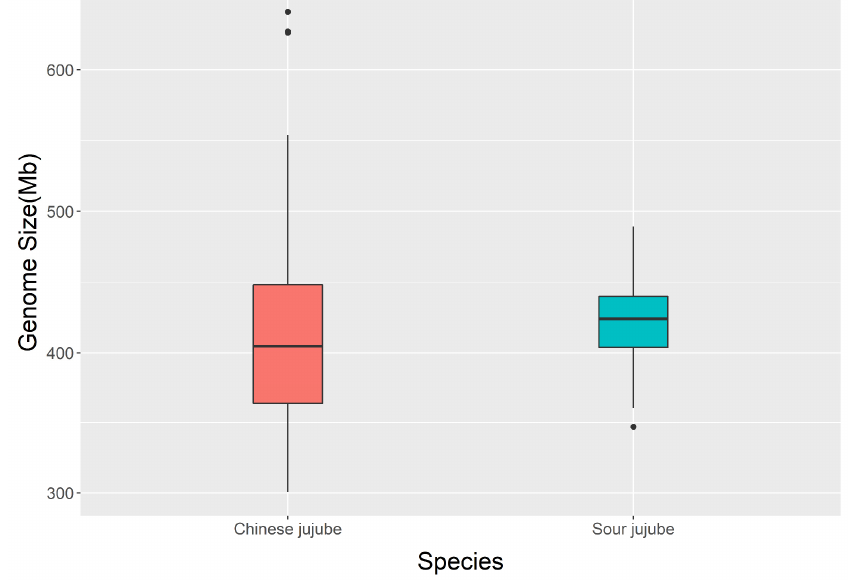
Figure 10. Boxplot of genome sizes in Chinese jujube and sour jujube. Each bar represents the median value of the genome size of either Chinese jujube or sour jujube.